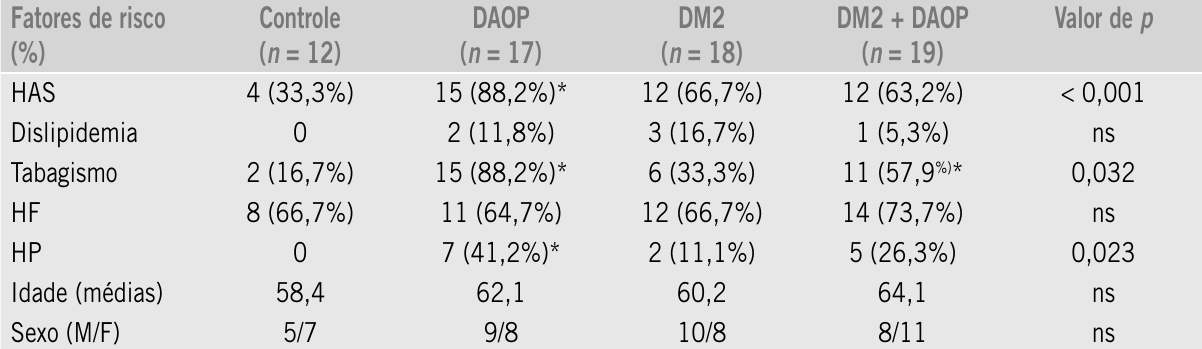
Tabela 1 Caracterização dos grupos quanto aos fatores de risco para desenvolvimento de